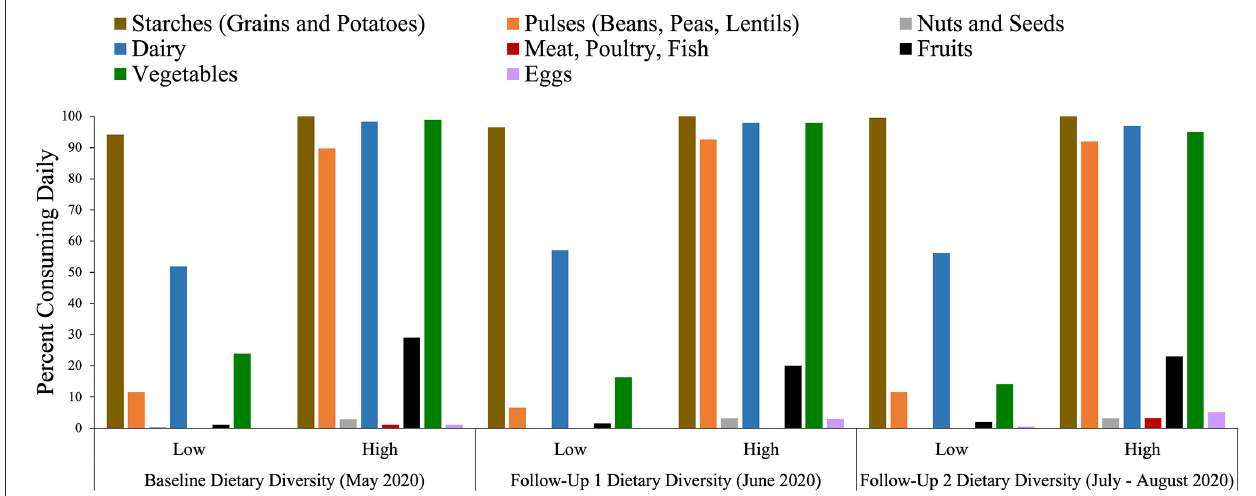
FIGURE 2 | Food groups contributing to low vs. high dietary diversity over time in participants from agricultural households across 12 states in India during the COVID-19 pandemic ( n = 833). Low dietary diversity defined as < 4 dietary diversity score and high dietary diversity defined as ≥ 4 dietary diversity score out of a total of